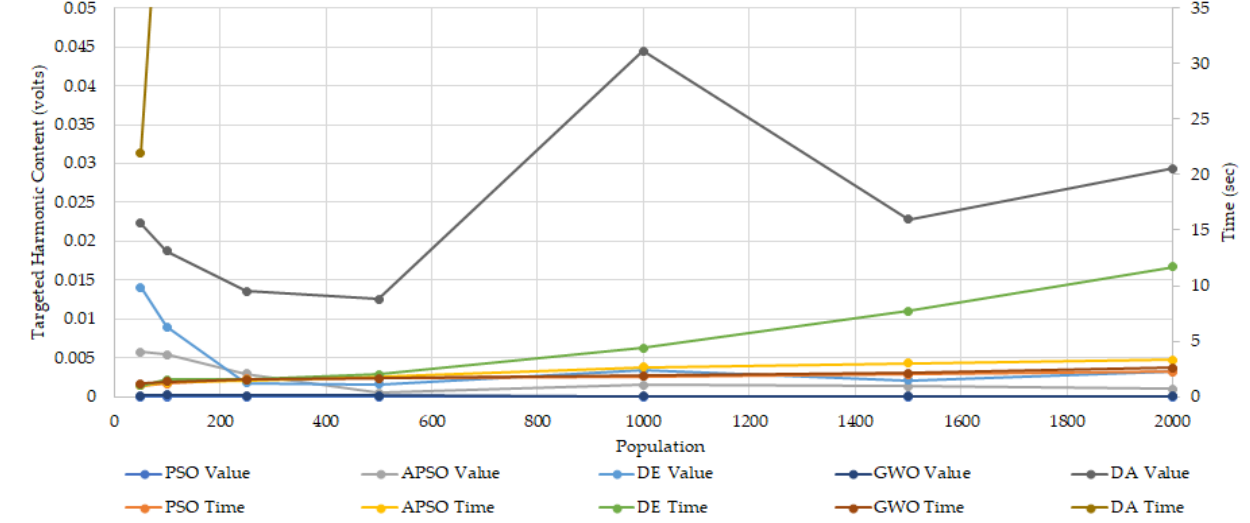
Table 2 . Percentage harmonics (w.r.t. fundamental) for seven-level CHB inverter.